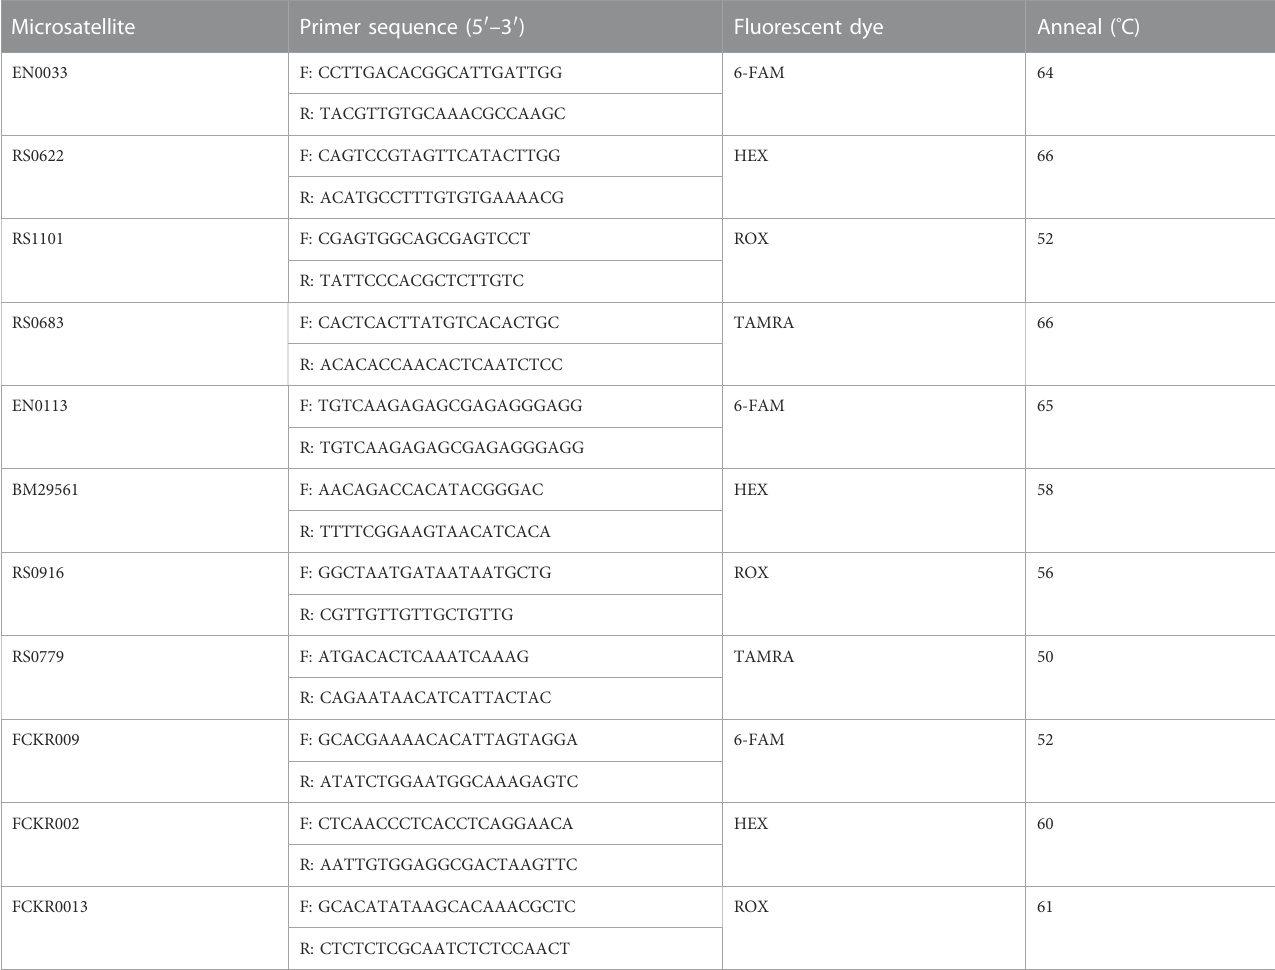
TABLE 2 Primer sequences, fl uorescent dyes, and anneal of microsatellites.